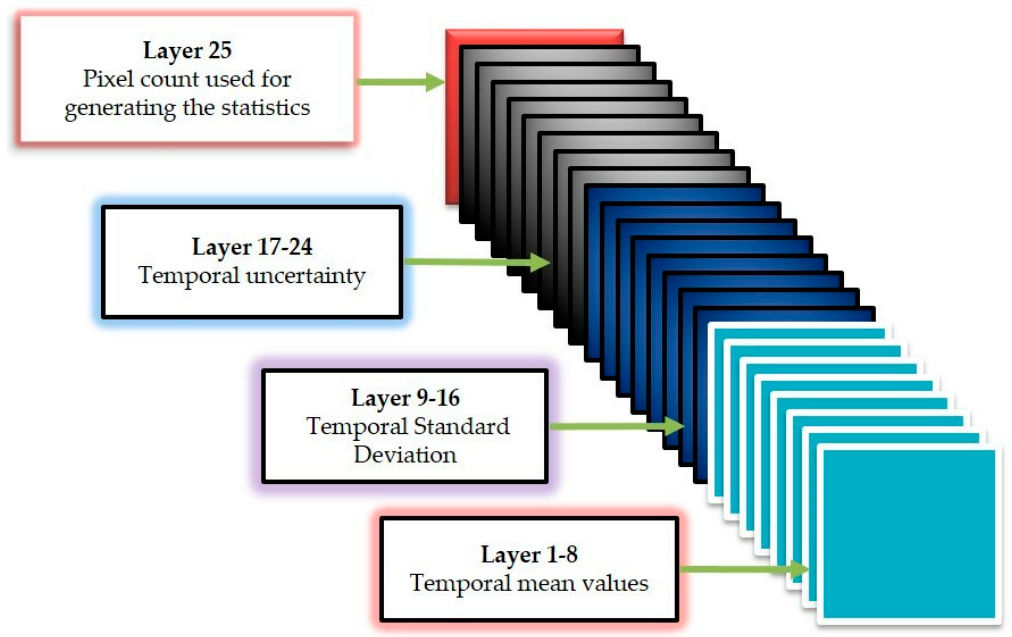
Figure 1. SDSU Data Tile Layers Derived from Google Earth Engine (GEE).